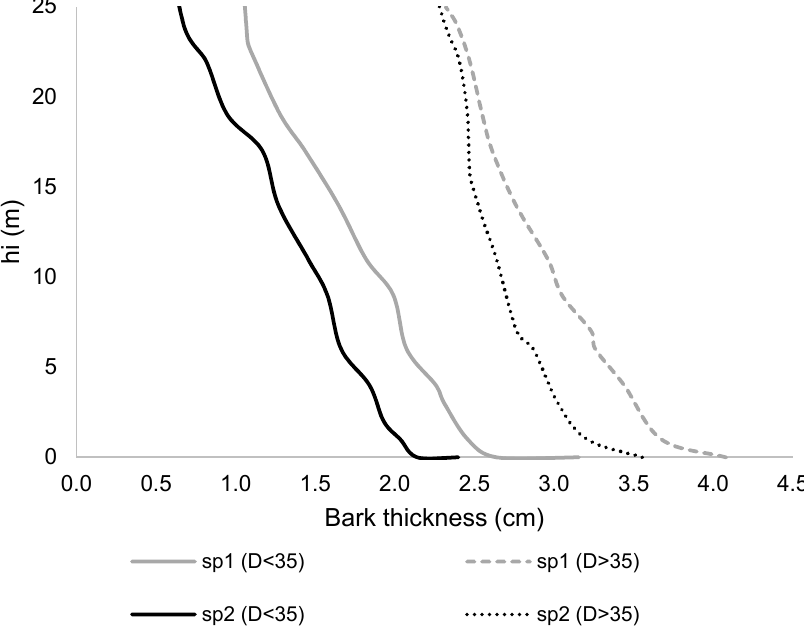
Figure 5. Predicted bark thickness (cm) across tree height (m) for two diameter ( D ) classes above and below 35 cm for trees of both species under study. hi: measurement height (m); D: diameter at breast height (cm): sp1: Pinus cooperi ; sp2: Pinus durangensis .